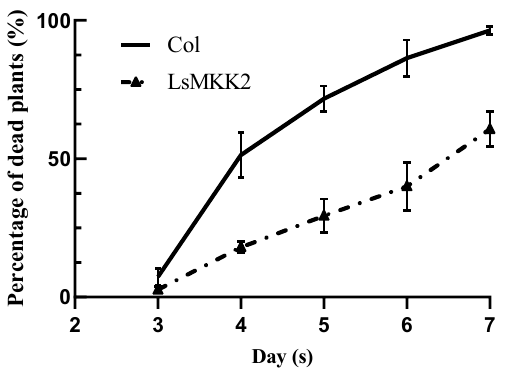
Figure 5. Lethal salt concentration treatment with genetically modified and WT plants. Quantification of plant lethality during a 7-day 200 mmol / L NaCl salt treatment.